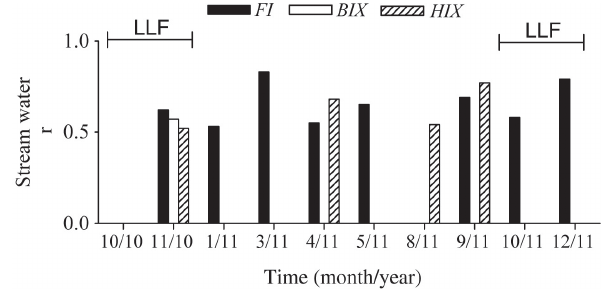
Figure 6. Temporal pattern of the standardized regression coeffi- cient ( r ) obtained by fitting linear regression models to values of spectroscopic indexes measured along the 4km study reach. The r is shown for the fluorescence index (FI), biological index (BIX), and humification index (HIX) in stream water. For each sampling date, r >0 indicates that values for a particular spectroscopic index increased significantly in stream water along the study reach. Bars are shown only when the model was significant ( p <0.05). The leaf litter fall (LLF) period is indicated. Note that none of the three spec- troscopic indexes showed significant longitudinal patterns for ripar- ian groundwater in any of the sampling dates.